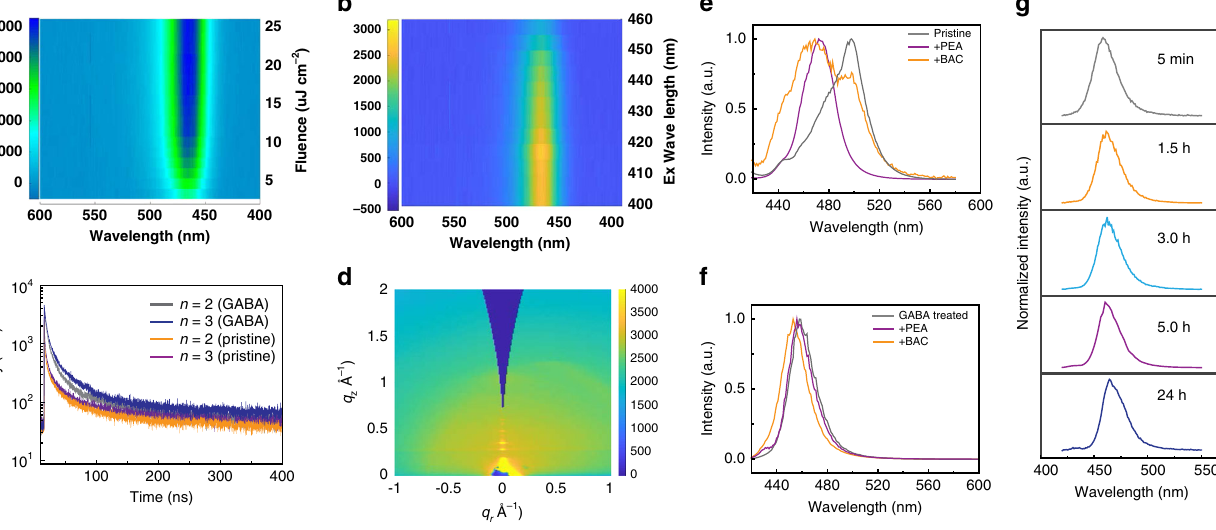
Fig. 4 Optical characteristics of GABA-treated CsPbBr 3 QWs. a Power-dependent photoluminescence spectra of GABA-treated CsPbBr 3 thin fi lms. b Excitation wavelength-dependent photoluminescence spectra of GABA-treated CsPbBr 3 thin fi lms. c Time-resolved photoluminescence (TRPL) decay of control and GABA-treated CsPbBr 3 fi lms. d GIWAXS pattern of CsPbBr 3 thin fi lms with GABA treatment. e , f Photoluminescence features under acidic (BAC) and basic (PEA) conditions for the control ( e ) and GABA-treated ( f ) CsPbBr 3 QW fi lms. g Thermal stability of GABA-treated CsPbBr 3 QW fi lms under 100 °C within the timeframe of 24 GABA is incorporated in the fi lms, while pristine fi lms are fea- a fl at and continuous fi lm over a 2 μ m area (Fig. 3a). In contrast, the control CsPbBr 3 QWs shows a rougher fi lm (Fig. 3b). Atomic force microscopy (AFM) images of GABA-treated CsPbBr 3 QWs show a smoother morphology with an RMS of around 0.3 nm, which is much lower than that of control fi lm (13.1 nm) (Fig. 3e, f). The better morphology of GABA-treated fi lm is linked to improved control of crystallization and QW size distribution, as Fig. 3a). The GABA-treated QWs exhibit no spectral shift with evidenced by TAS 19 . Powder X-ray diffraction (PXRD) of control and GABA-treated fi lms show typical perovskite diffraction sig- increasing excitation power, while control fi lms show a 5 nm nals (Fig. 3c). Fourier transform infrared spectroscopy (FTIR) shift. PL excitation (PLE) spectra of pristine and GABA-treated spectra of GABA-treated CsPbBr 3 QWs show clear C = O CsPbBr 3 QWs (< n > = 2) exhibit single emission peaks (463 and absorption features at a 1500 – 1700 cm − 1 , which con fi rms that 495 nm for GABA-treated and control fi lm, respectively) (Fig. 4b